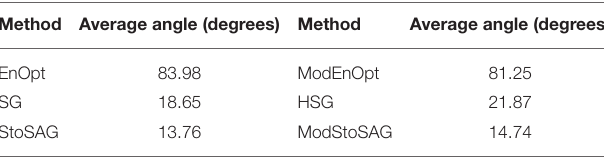
TABLE 3 | Average angles between the search directions obtained using FDM and the stochastic gradients for σ m = 1.0. Method Average angle (degrees) Method 83.98 81.25 21.87 13.76 ModStoSAG 14.74 The angle calculations are repeated 100 times and